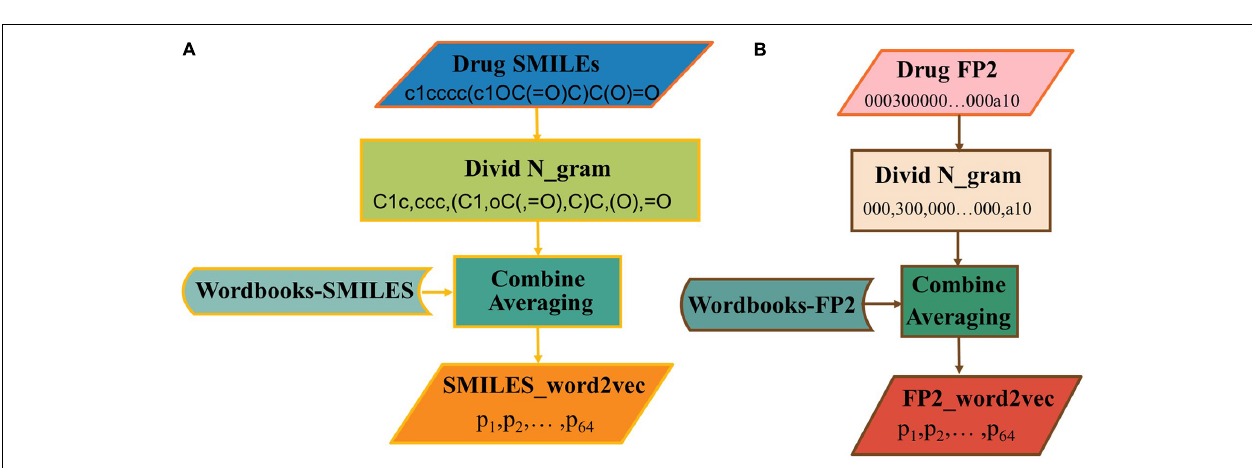
Frontiers in Genetics | www.frontiersin.org